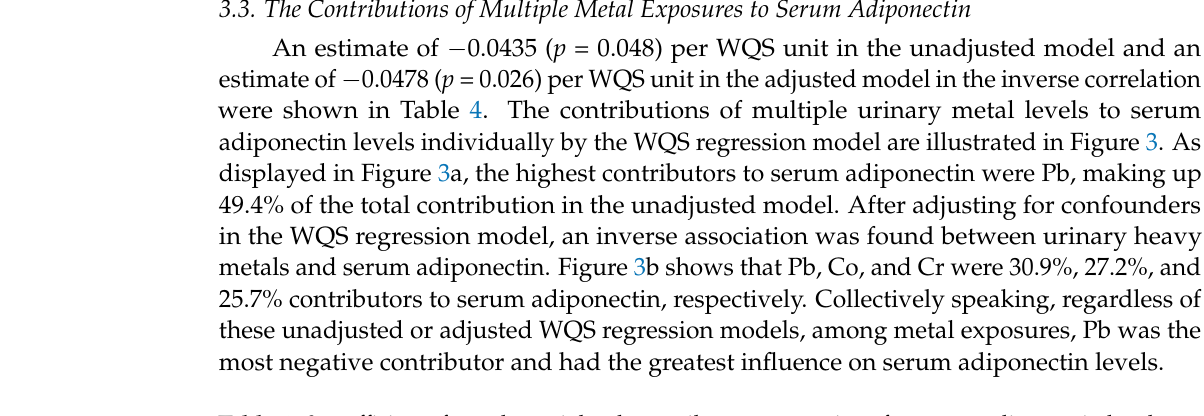
Table 4. β coefficients from the weighted quantile sum regressions for serum adiponectin